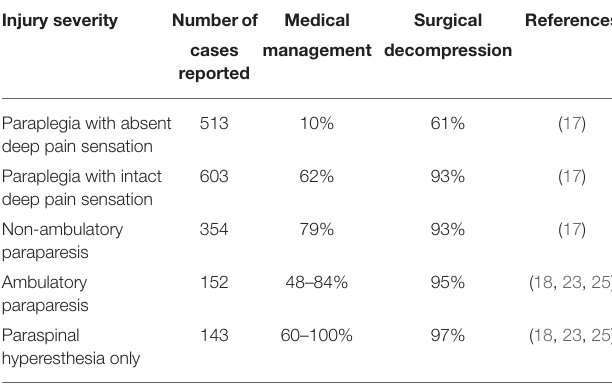
TABLE 3 | Overall percent of dogs achieving neurologic recovery (defined as independent ambulation) based on presenting injury severity, as reported in the literature after 1983 by Langerhuus and others for medical and surgical management of canine thoracolumbar interverterbral disc herniation